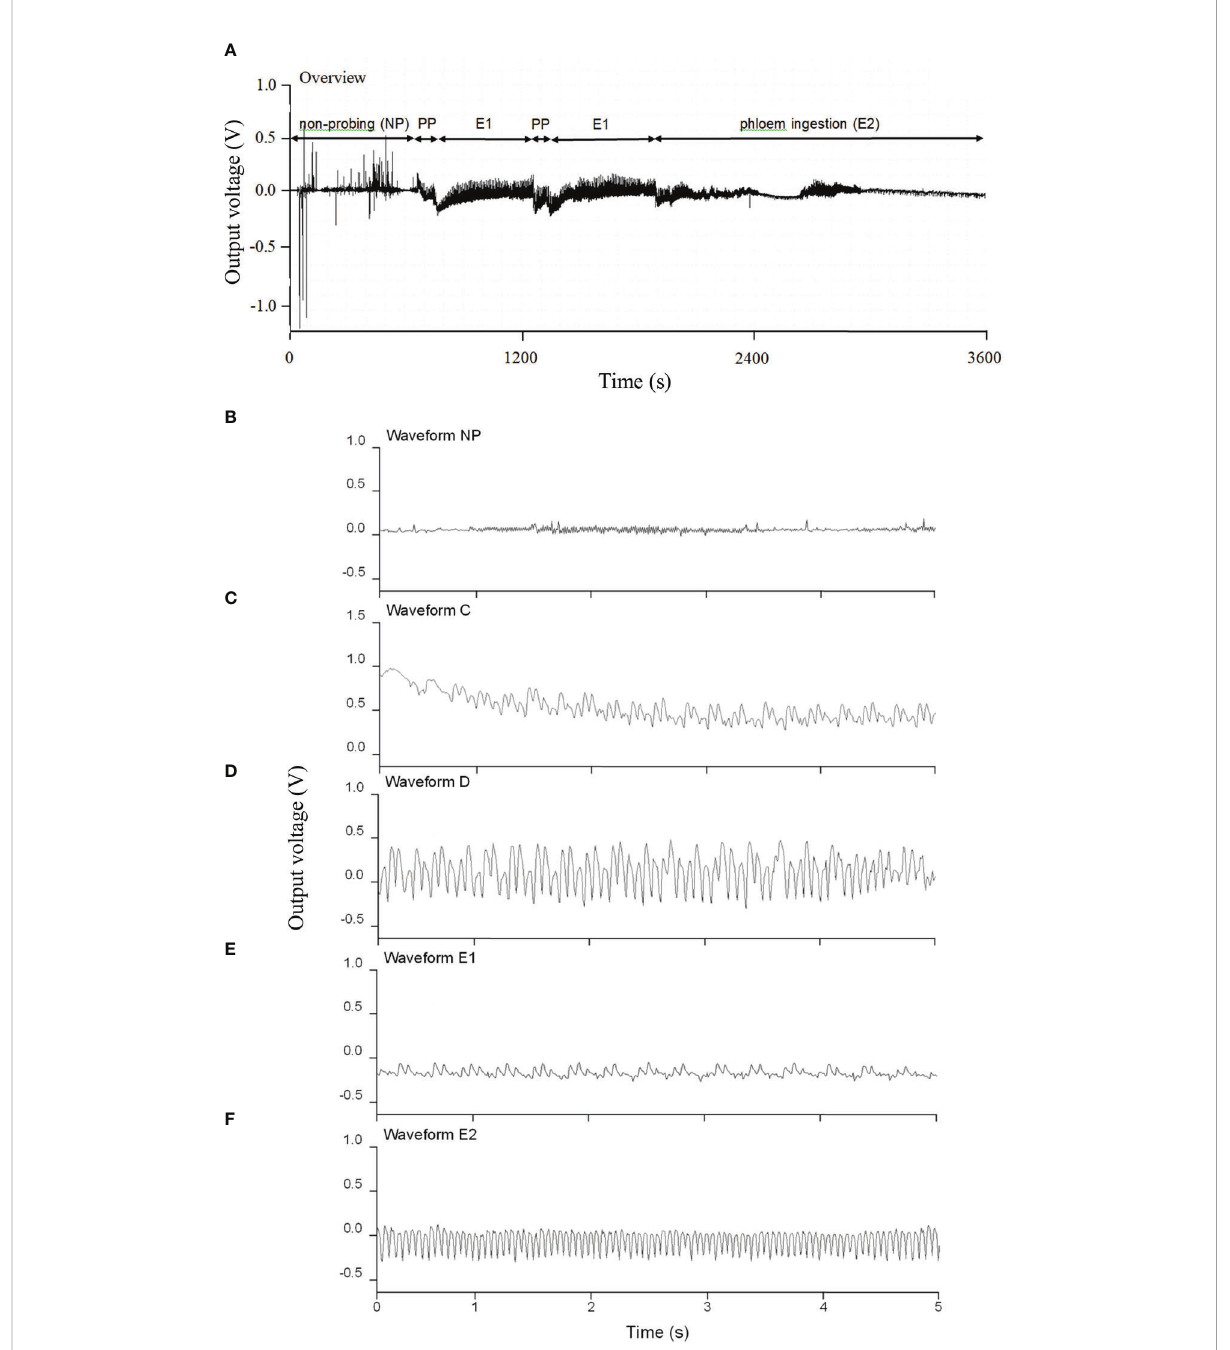
FIGURE 2 Typical electrical penetration graph (EPG) of an adult Diaphorina citri feeding on Nicotiana tabacum leaves. (A) EPG trace for the fi rst 1 h after the start of assessment (NP = non-probing phase; PP = pathway phase (C + D), including intercellular probing of activity in the phloem (C) and phloem penetration (D) ; E1 = phloem salivation; E2 = phloem ingestion). (B) Enlargement of waveform NP. (C) Enlargement of waveform C. (D) Enlargement of waveform D. (E) Enlargement of waveform E1. (F) Enlargement of waveform